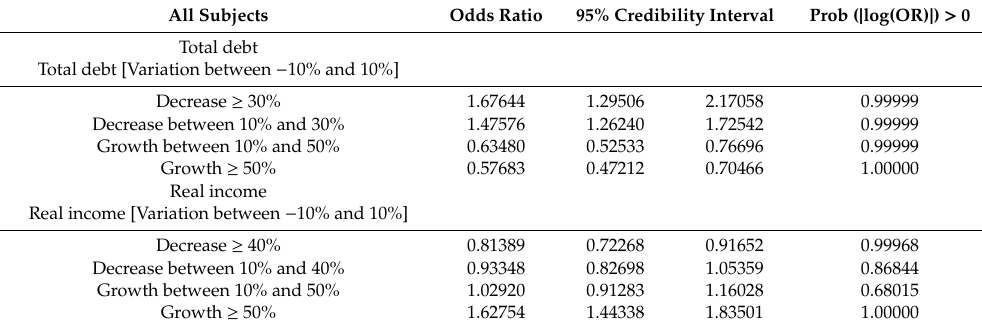
Table 6. Association between the variation in wealth and real income and good and very good self-perceived health.